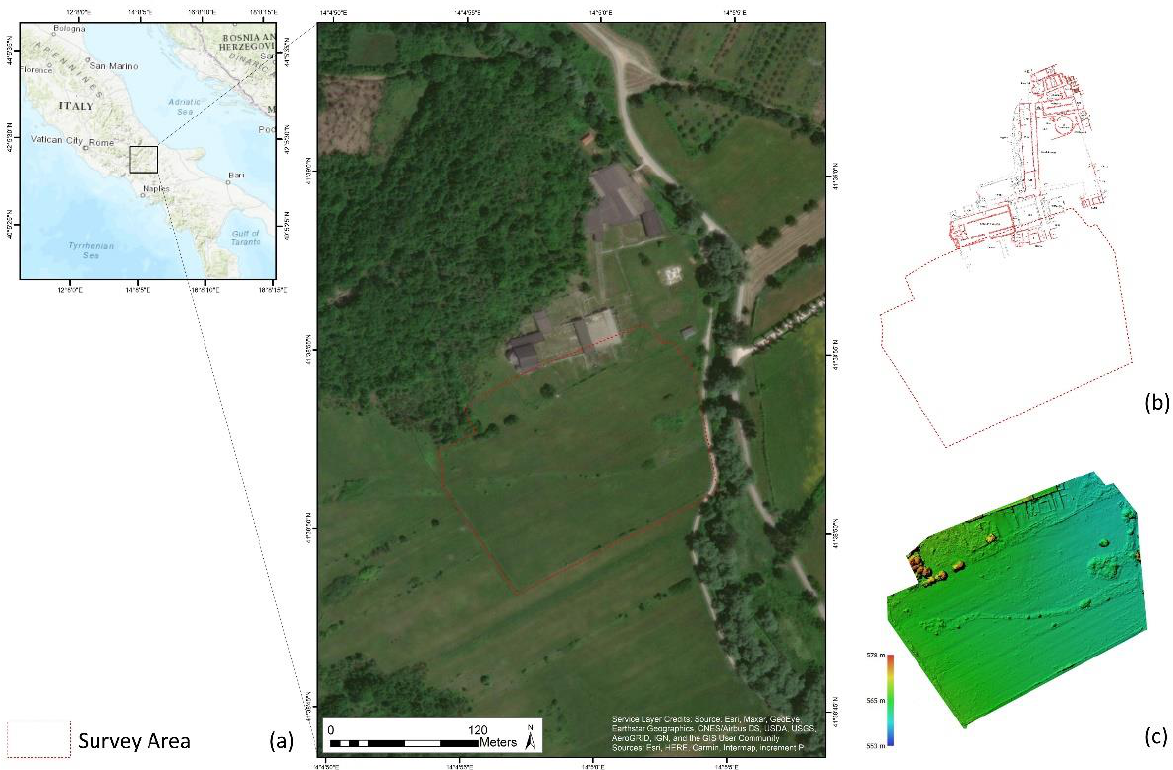
Figure 1. Archaeological area of San Vincenzo al Volturno (Isernia, Molise, Italy): ( a ) location of the survey area; ( b ) overlay of the survey area with the structures surveyed by archaeologists during excavations (1980–2019); ( c ) digital elevation model (DEM) obtained from the image acquired on 16 July 2019. The coordinate system used was WGS 1984 UTM Zone 33N; EPSG: 32633.